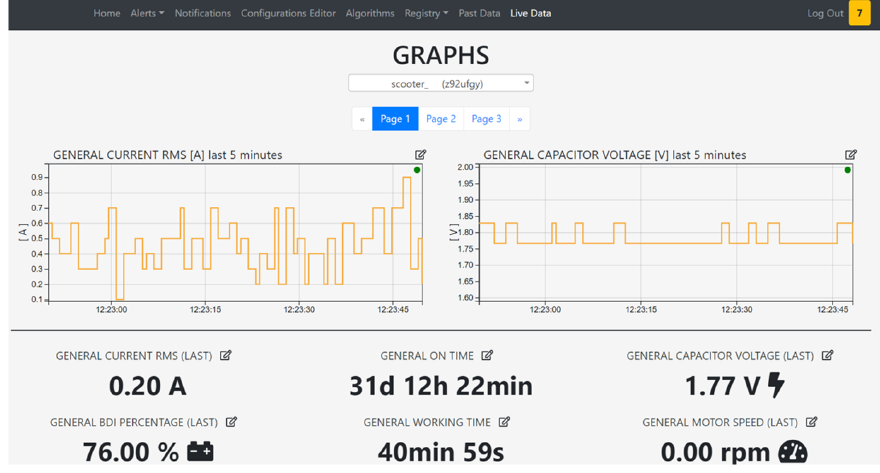
Figure 9. Server dashboard page.